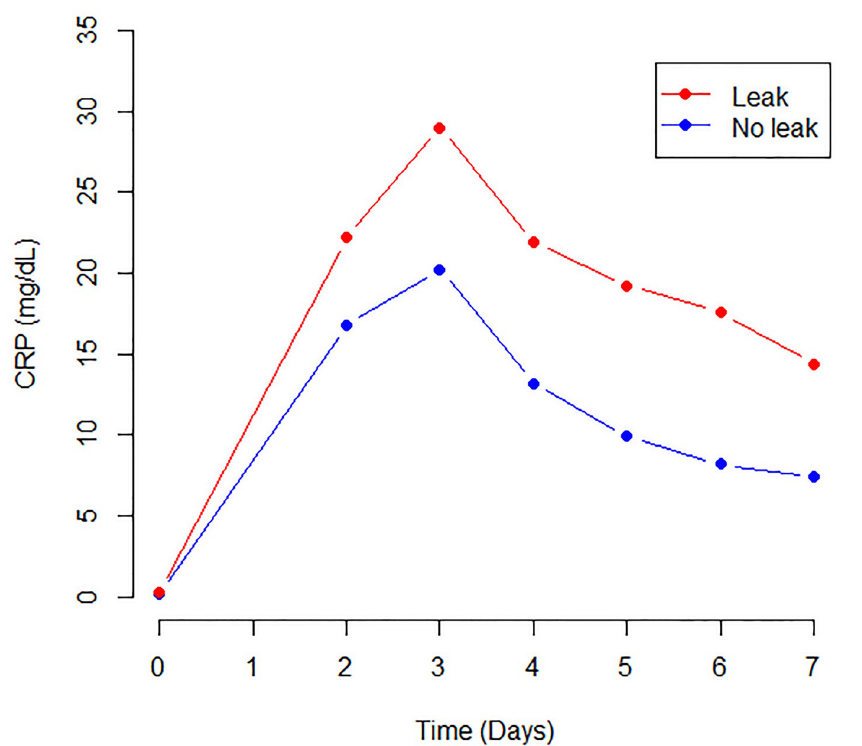
Fig 3. Pooled post-operative CRP levels in the two patients groups ( p < 0.05).